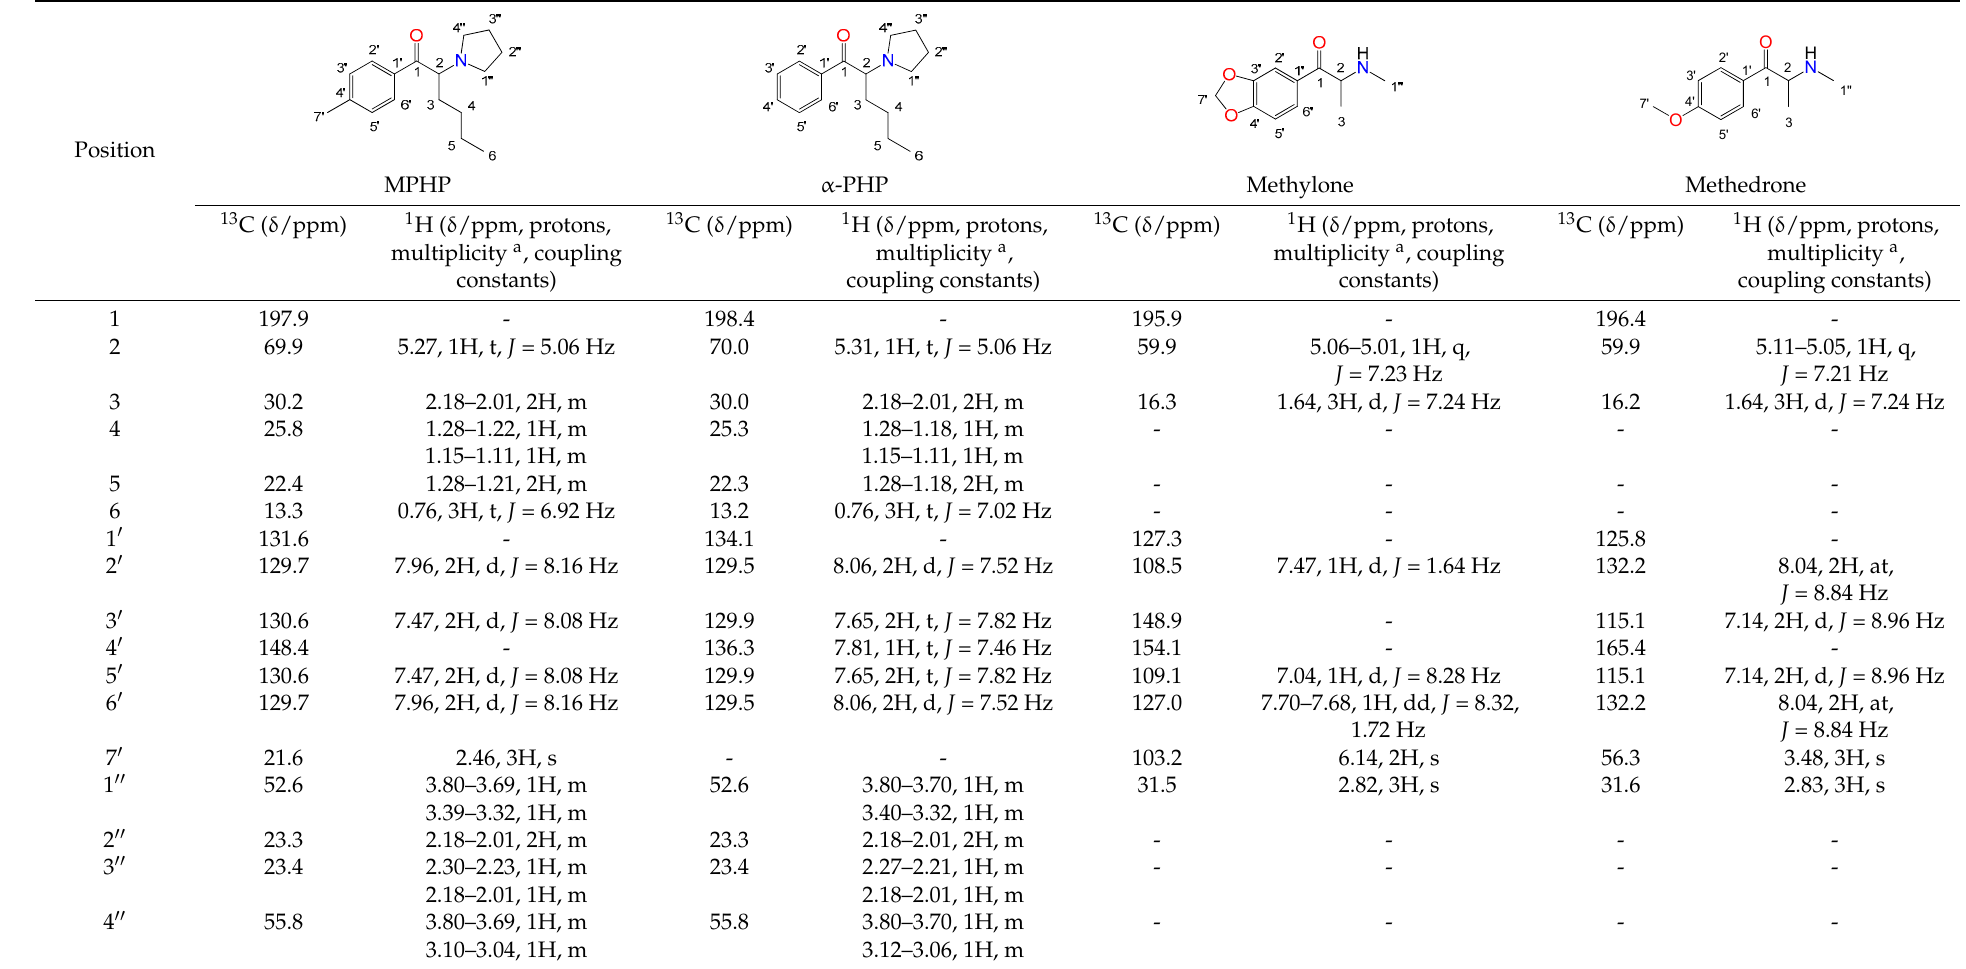
Table 3. NMR assignments of SCat constituted by a pyrrolidine ring in the side chain or a methoxy or a methylenodioxy group attached to the aromatic ring.